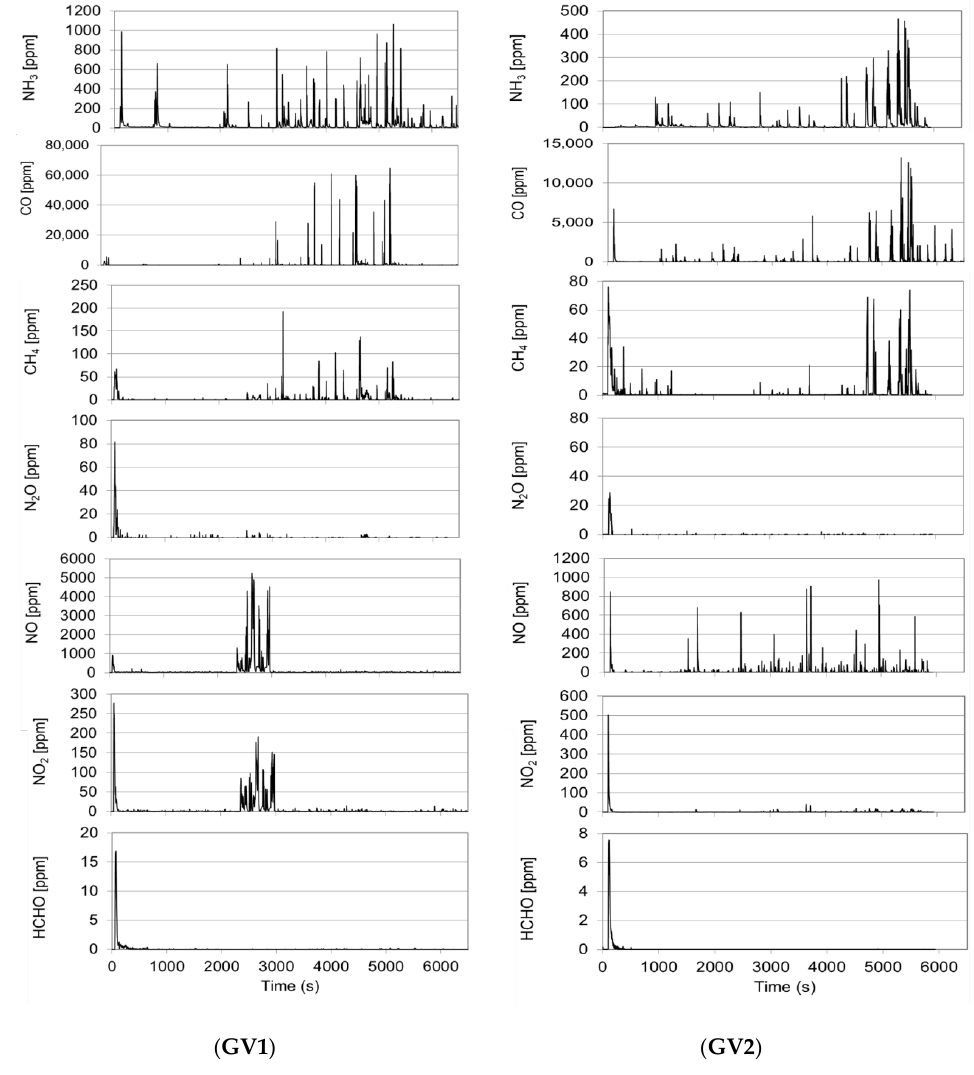
Figure 3. NH 3 , N 2 O, NO, NO 2 , CO, CH 4 , and HCHO on-road emissions profiles registered for the GV1 during the dynamic test on Route-2 (left panels) and for the GV2 during the RDE test on Route-1 (right